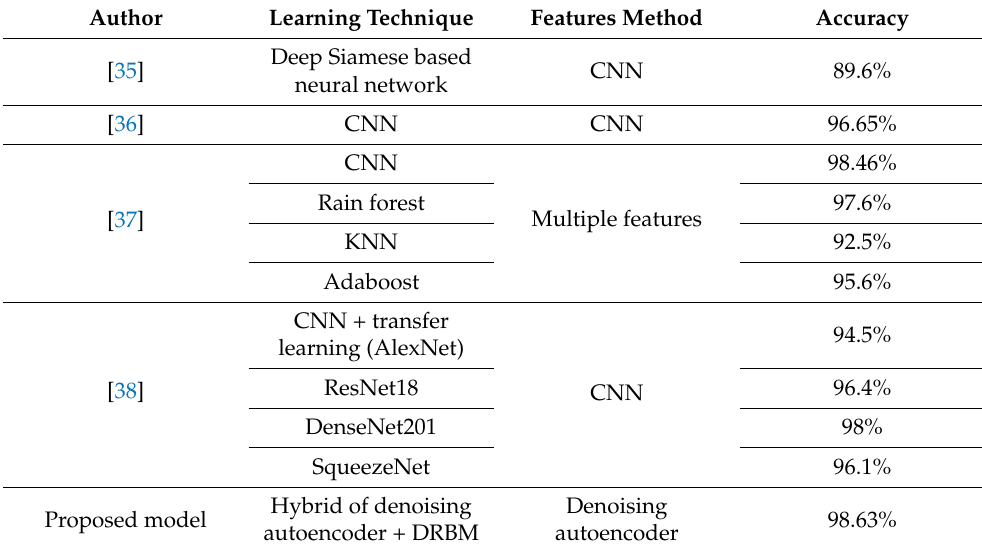
Table 3. Comparison analysis of different methods for feature selection and